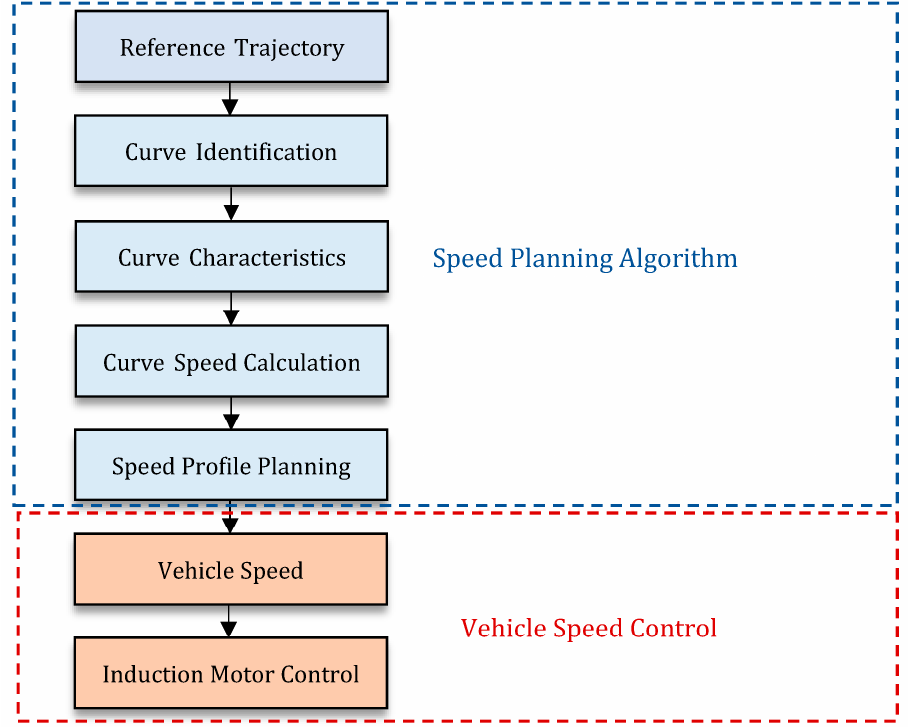
Figure 5. Overall diagram of vehicle speed control system.